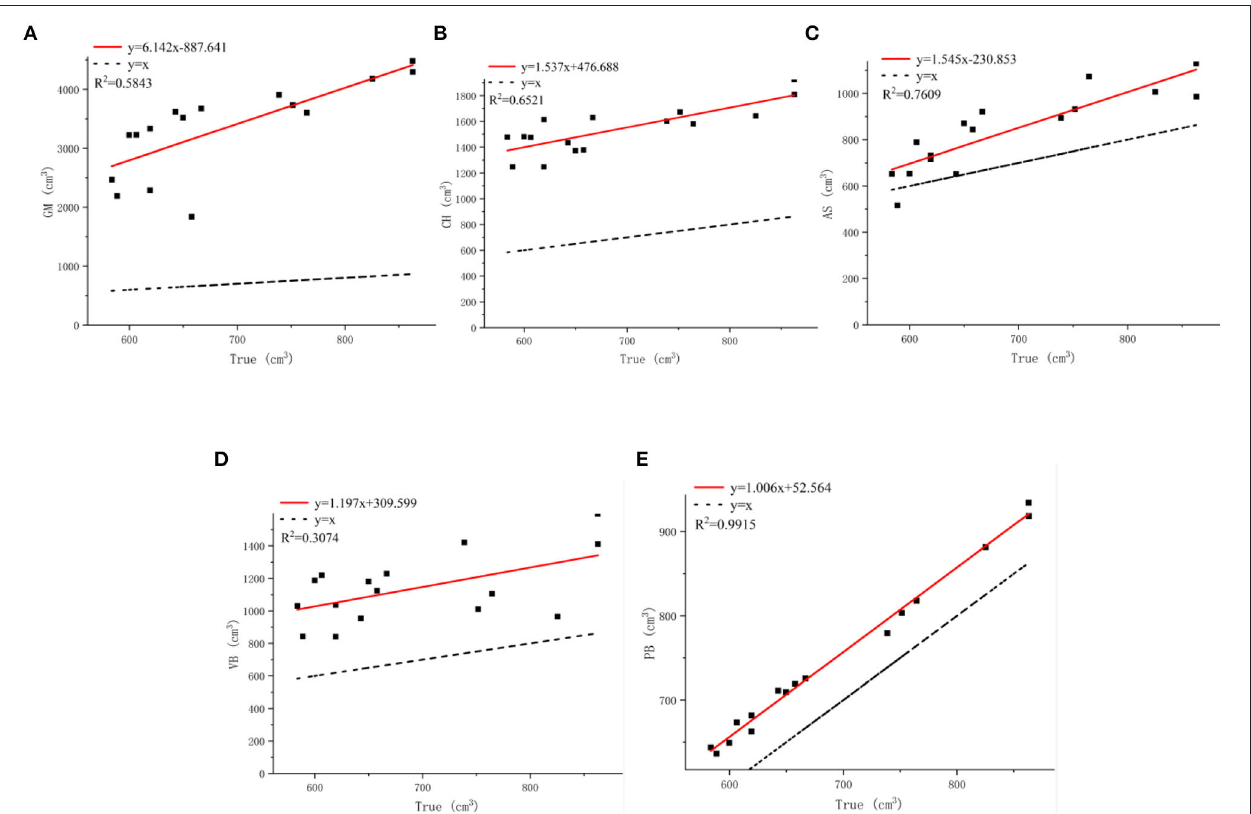
FIGURE 14 | Analysis of grape estimators. (A) Comparison of true and GM. (B) Comparison of true t and CH. (C) Comparison of true and AS. (D) Comparison of true and VB. (E) Comparison of true and